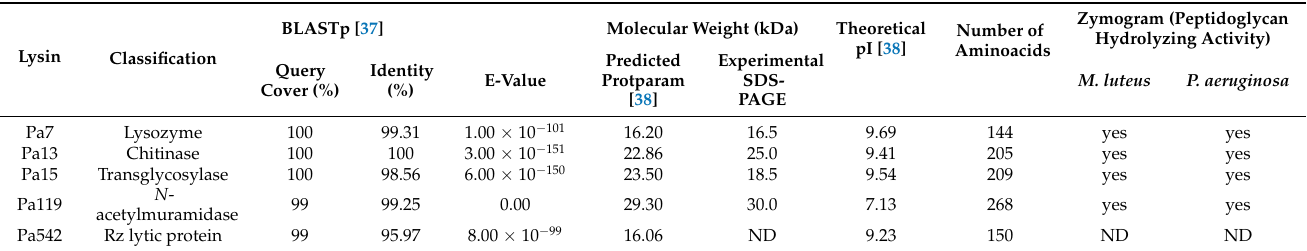
Table 3. Selected lysins